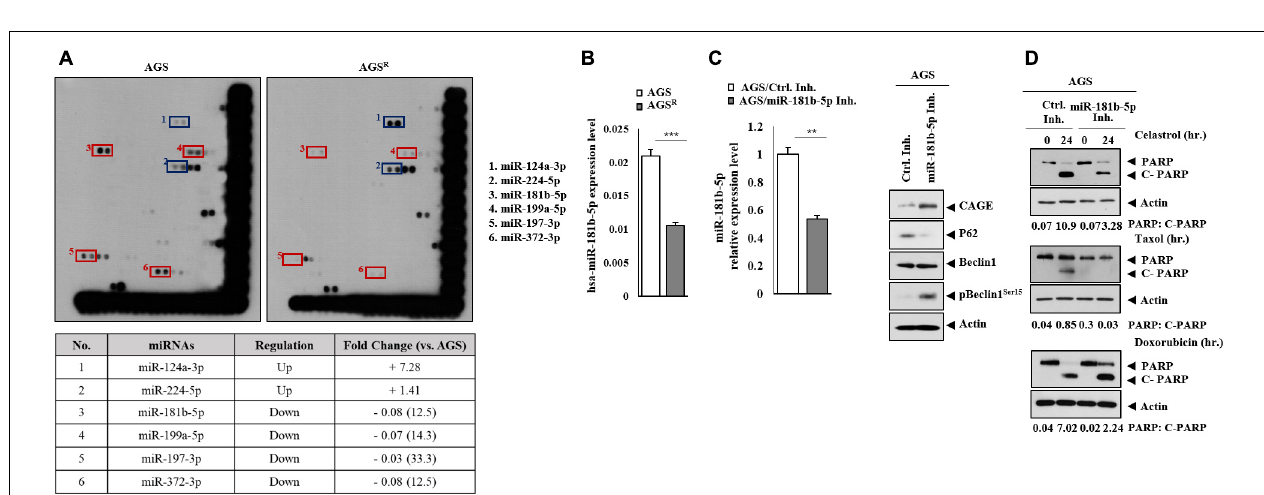
FIGURE 8 | MiR-181b-5p negatively regulates the expression of CAGE, autophagic flux. (A) MicroRNA array analysis was performed. The red rectangles show miRNAs expressed highly in AGS cells. The blue rectangles show miRNAs expressed highly in AGS R cells. (B) qRT-PCR analysis was performed. ***, p < 0.001. Average values of three independent experiments are shown. (C) After 48 h of transfection with the indicated inhibitor (each at 10 nM), qRT-PCR and immunoblot were performed. **, p < 0.01. Average values of three independent experiments are shown. (D) AGS cells were transfected with the indicated inhibitor (each at 10 nM). The following day, the cells were then treated with or without celastrol (1 µ M) or Taxol (1 µ M) for 24 h, followed by immunoblot. Representative blots of three independent experiments are